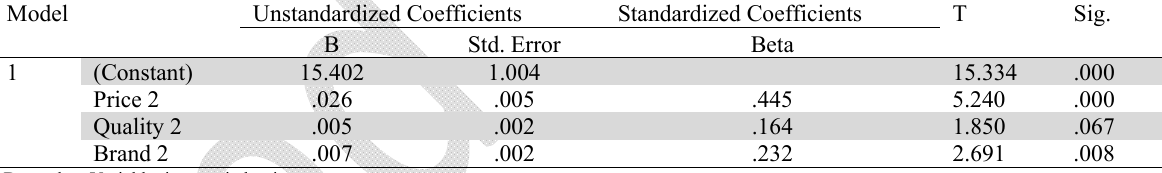
Model 11 Multiple Linear Regression Test Results (Coefficients a )